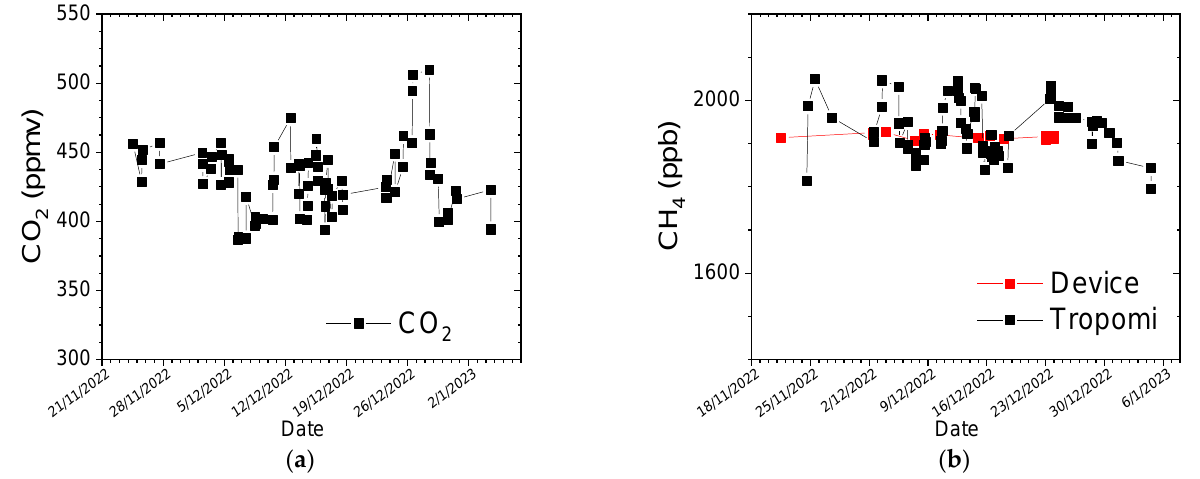
Figure 9. Concentration variation in ( a ) CO 2 and ( b ) CH 4 in the atmosphere from 24 November 2022 to 4 January 2023.